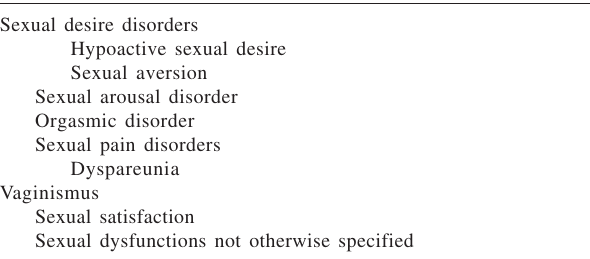
Table 2 - Categories of female sexual